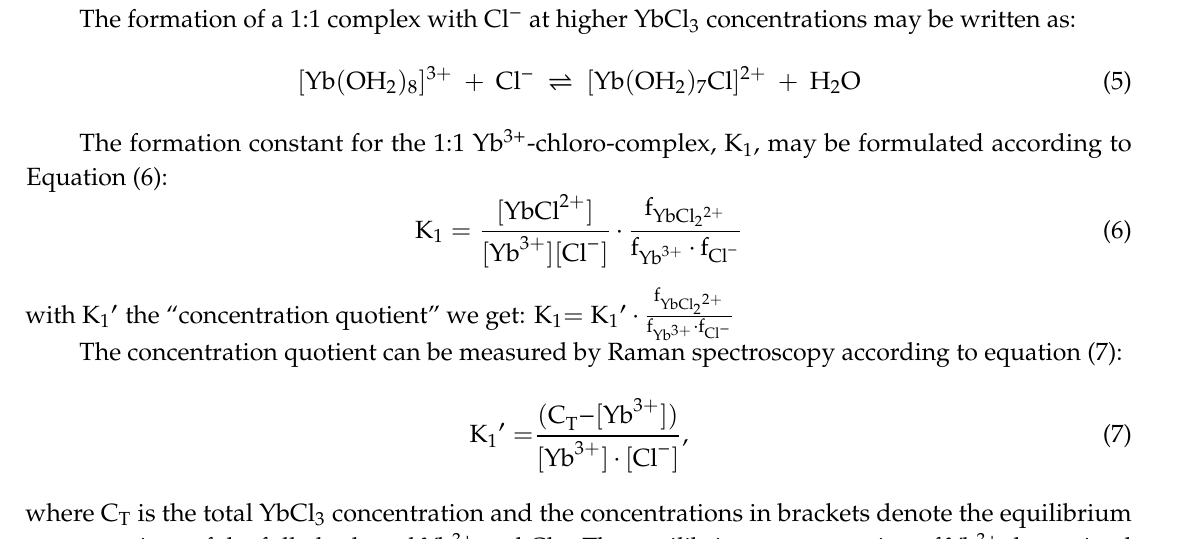
738 cm − 1 to 789 cm − 1 in going from a 3.224 mol·L − 1 solution to the one at 0.802 mol·L − 1 .